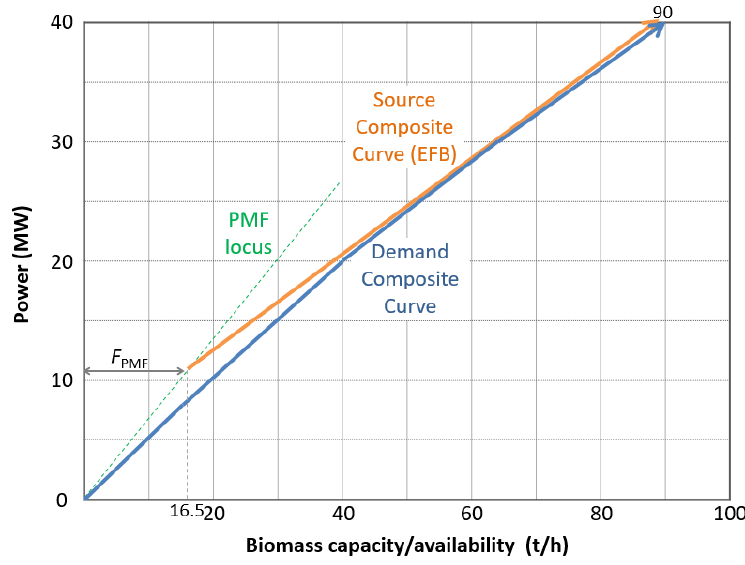
Figure 8. BEPD when two biomass types are used (Scenario 2).